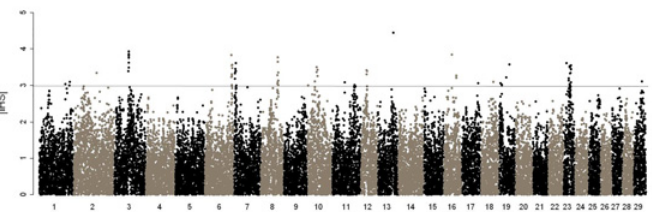
Fig 2. Genome-wide plot of standardized |iHS|. Each dot represents |iHS| of a SNP that is located at the center of an extended haplotype (10 Mb) plotted against its genome coordinate on UMD 3.1. Dotted line is |iHS| = 3.